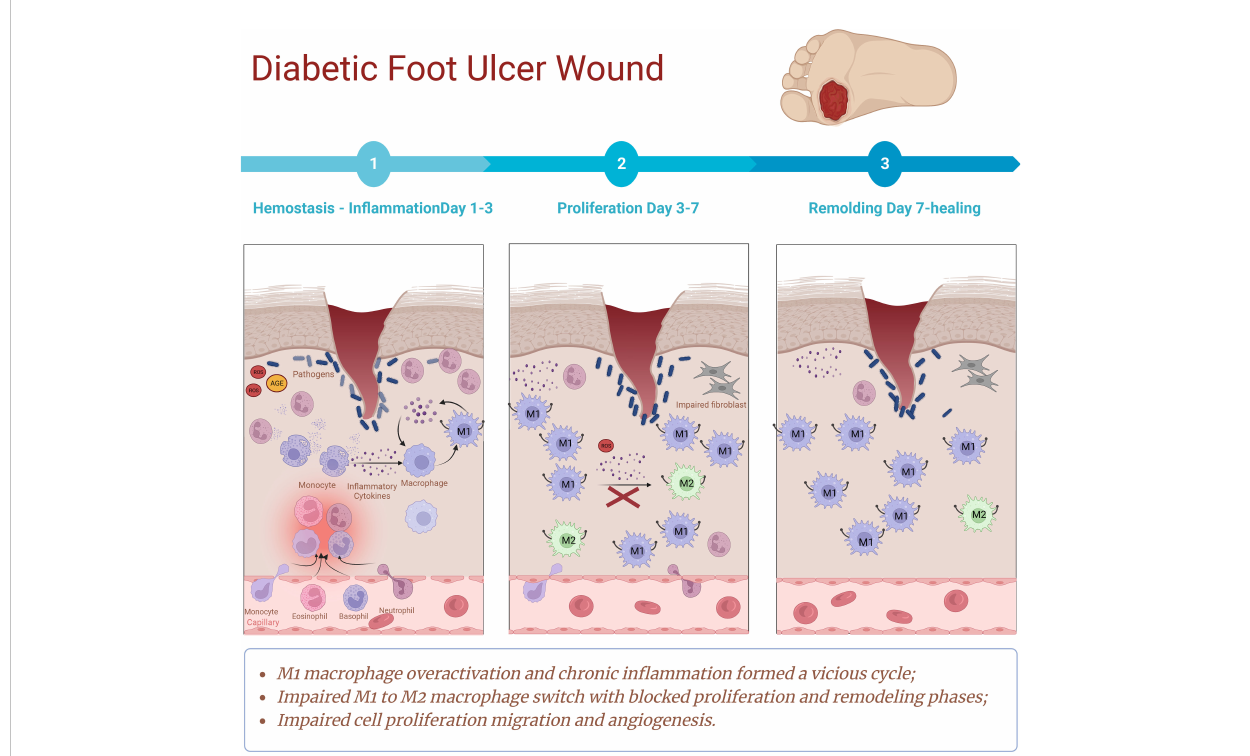
FIGURE 7 The molecular mechanisms of macrophage pathophysiological process in DFUs. Macrophages play a crucial role in routine wound healing, promoting angiogenesis, collagen deposition and wound closure. Over-activation of M1 macrophages and impaired transition from M1 to M2 phenotype are essential differences between normal and diabetic wound healing. In normal wounds, macrophages clear pathogens and cellular debris by activating a pro-in fl ammatory phenotype. As the in fl ammatory phase progresses, macrophages shift from pro-in fl ammatory phenotype to pro-repair phenotype. As a result, it stimulates the proliferation, differentiation and migration of keratinocytes, fi broblasts and endothelial cells by secreting cytokines and growth factors, which directly or indirectly regulate the proliferative phase of the repair process. However, in the microenvironment of diabetic wounds, perturbations associated with hyperglycaemia, advanced glycation end products, oxidative stress and impaired angiogenesis induce disturbances in the immune microenvironment of diabetic wounds, leading to phenotypic dysregulation as well as quantitative, functional, and epigenetic alterations in traumatic macrophages. As a result, M1 polarization is enhanced and the switch from M1 to M2 is severely impaired. This culminates in a situation where lower numbers of M2 macrophages and higher M1/M2 ratios release low levels of growth factors. Meanwhile, the diabetic microenvironment resulted in macrophage sensitivity to pro-in fl ammatory cytokines and stimulated macrophages to secrete pro-in fl ammatory cytokines such as IL-1, IL-6, MMP9, and TNF-a. This further exacerbates the vicious cycle of M1 macrophage polarization and chronic in fl ammation, causing stagnation of the in fl ammatory phase. Which created an excess in fl ammatory cytokines microenvironment, ultimately contributed to impaired fi broblast and keratinocyte migration and delayed wound